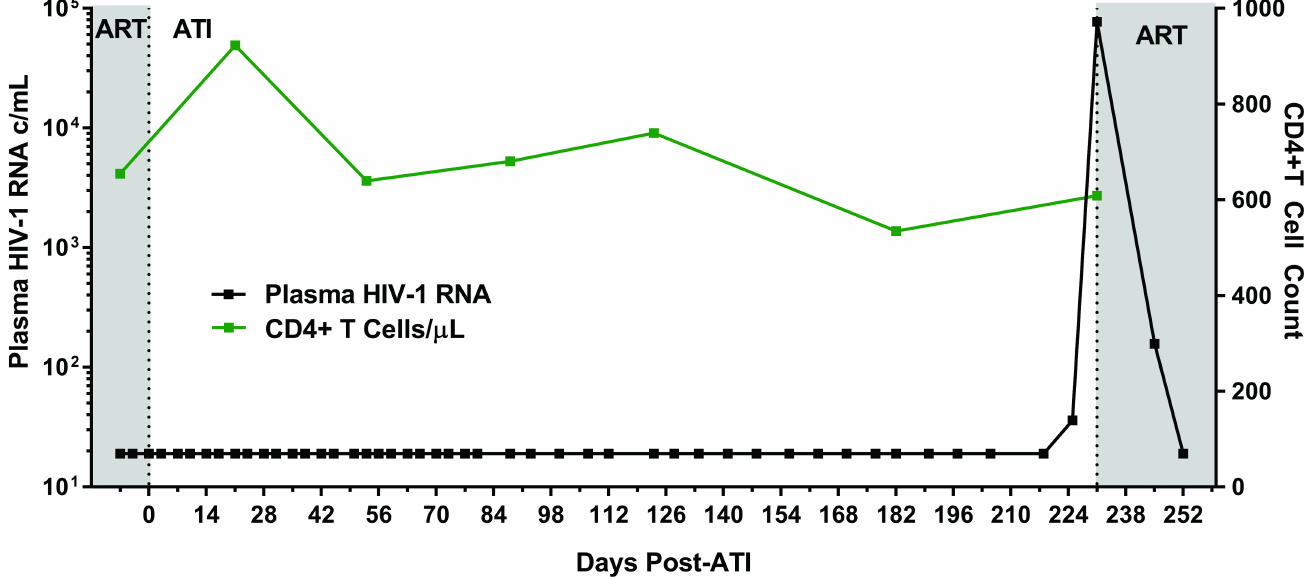
Fig 2. Summarytimeline of plasma viral load and CD4+ T cell counts following analytical ART treatment interruption in Participant A. Abbreviations: ART, antiretroviral therapy; ATI, analyticaltreatment interruption; c/mL, copies/mL.